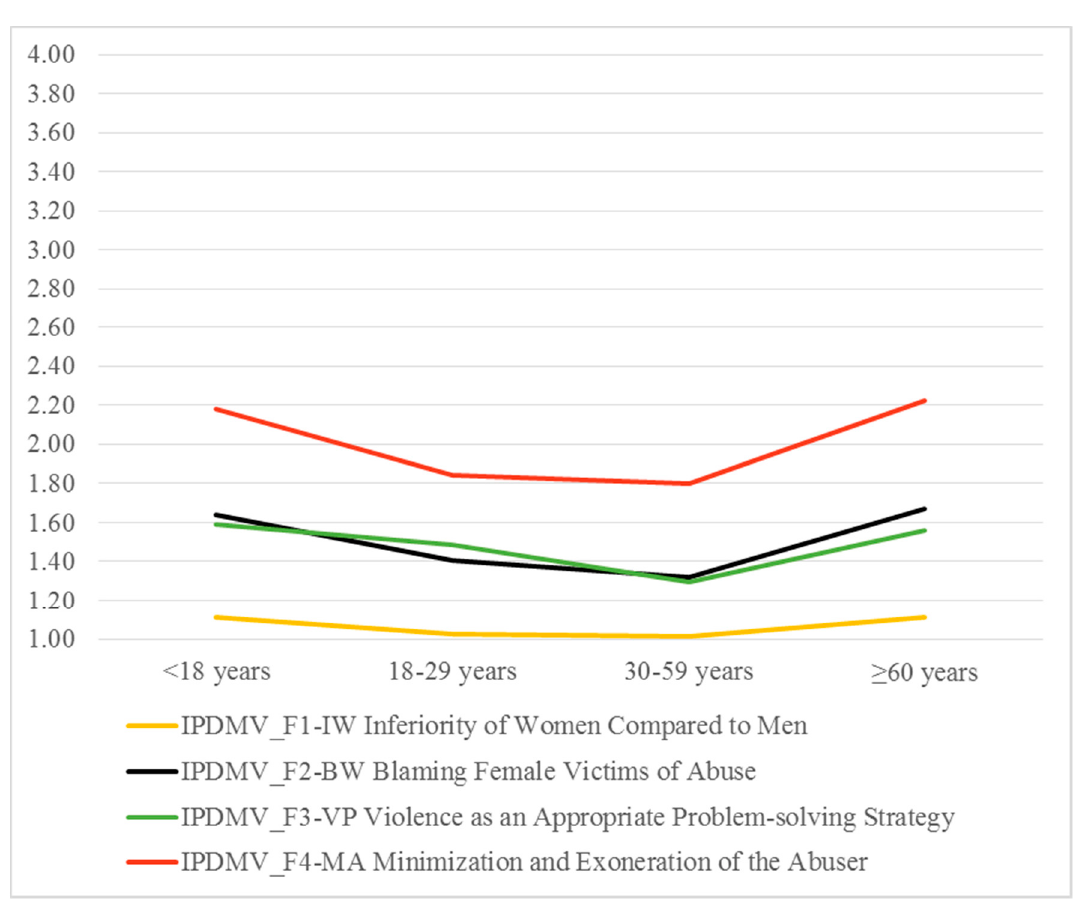
Figure 1. IPDMV: Means by age groups.